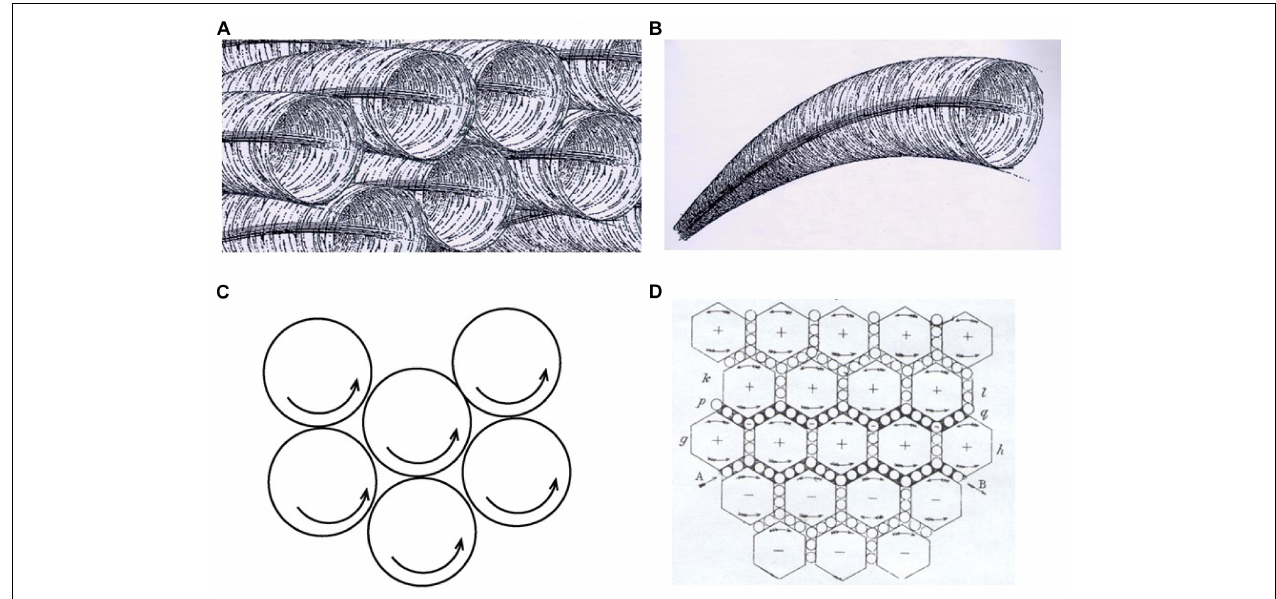
FIGURE 5 | Maxwell’s development of E&M theory via analog models. Below, specific tactical heuristics appear in lower case bold and model construction phases of the GEM cycle appear in capitalized bold letters. Starting from Faraday’s ‘lines of magnetic force’ around a magnet, the (simplified) reasoning processes for Maxwell are: (1) Model Generation (via using an analogy ): He imagined that the magnetic field is like a fluid with vortices (B) rotating in the same direction around each of the magnetic lines of force ( A - Nersessian’s rendition). This qualitative model, along with incorporating a continuum mechanics theory of fluid flow ( applying a schema ) inspired an initial mathematical model for basic magnetic phenomena, as summarized in Table 3 . (2) Model Evaluation ( by evaluating internal incoherence via running the model ): Mentally simulating the above system, Maxwell believed adjacent vortices would die out because of friction generated between vortices, just as gears turning in the same direction will jam if they touch (C) . This cast doubt on the initial model and became a constraint. (3) Model Modification (by analogy and adding a model element ): Maxwell transformed his model by adding small vortices between the larger vortices, analogous to ‘Idle wheels’ between gears, to enable the vortices to rotate without jamming or creating friction (D) . He makes the simplifying assumption that fluid vortices are inelastic and do not deform. This provided a way to model electromagnetic induction (the principle of the generator) and electric current in a wire. (4) Model Evaluation (by identifying a gap in the model ): Maxwell found a gap in the above model in not being able to account for static electricity and other phenomena when running the model in a mental simulation. (5) Model Modification (by altering a model element ): He transformed the model again by adding elasticity to the vortices, yielding a way to model the above phenomena. (6) Model Evaluation (by running the model to predict new Evaluatory Observations ): Mental simulation allowed him to predict the propagation of electromagnetic waves through space (also from equations). Confirmation of this prediction after Maxwell’s death by Hertz’s discovery of radio waves was a sensational contribution to confirming Maxwell’s theory (see summary in Table 3 ). (From Nersessian, 2008 p. 138, © 2008 Massachusetts Institute of Technology, by permission of The MIT Press).